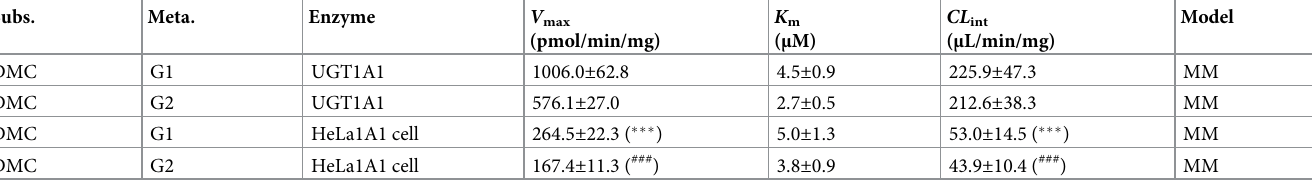
Table 1. Kinetic parameters derived from DMC- O -glucuronidation by UGT1A1 and HeLa1A1 cell lysate. Subs. Meta.